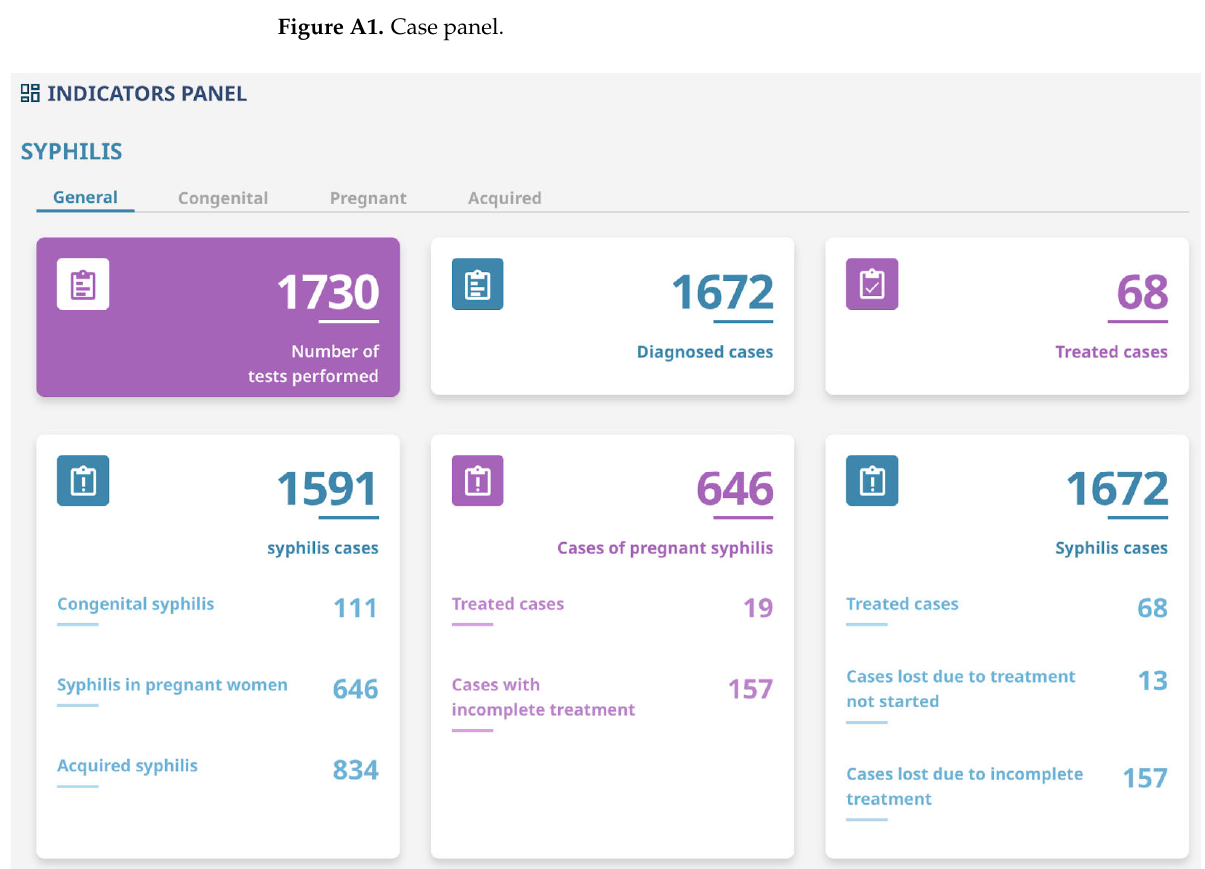
Figure A2. Indicators panel.